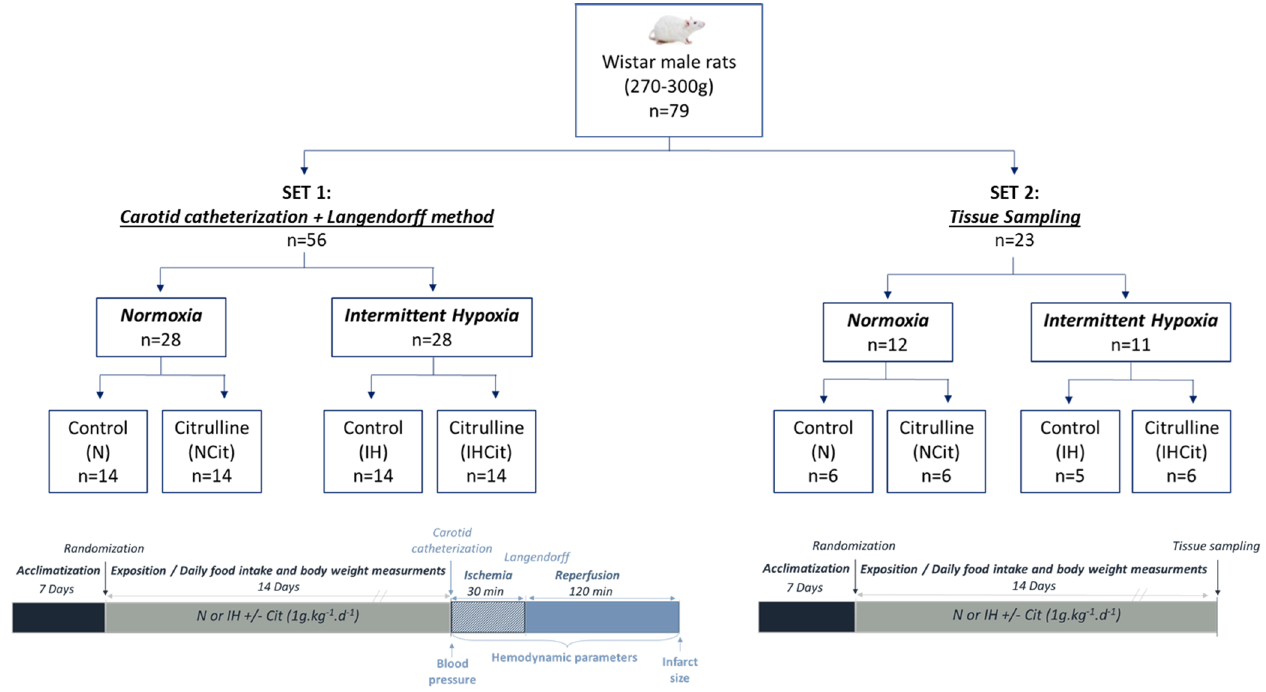
Figure 1. Experimental groups and design. Seventy-nine rats were separated into 2 sets. Both sets of rats were randomized into normoxia (N) or intermittent hypoxia (IH; 8 h per day, 30 s of 21% O 2 ° and 30 s of 5% O 2 ) for 14 days, supplemented with 1 g·kg − 1 ·d − 1 citrulline (Cit) or not (Control). At the end of exposure, rats from set 1 were subjected to blood pressure measurements by carotid catheterization. Afterward, the hearts were isolated and perfused by the Langendorff method and submitted to ischemia (30 min) and reperfusion (120 min) protocols, during which the hemodynamic parameters and, in the end, infarct size were measured. Rats from set 2 were euthanatized after 14 days of exposure for blood collection and tissue sampling for further biochemical analyses.